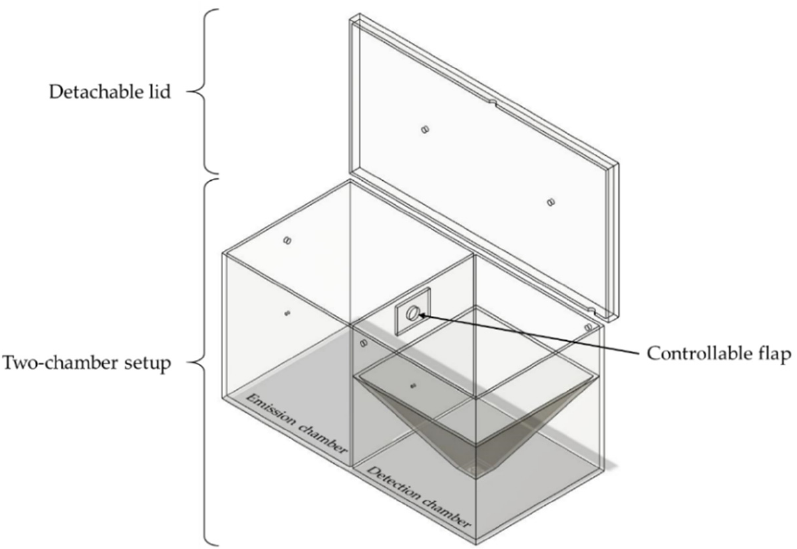
Figure 1. Simplified illustration of the TCS in the open state, consisting of a detachable lid, a con- trollable flap, and the two connected chambers.